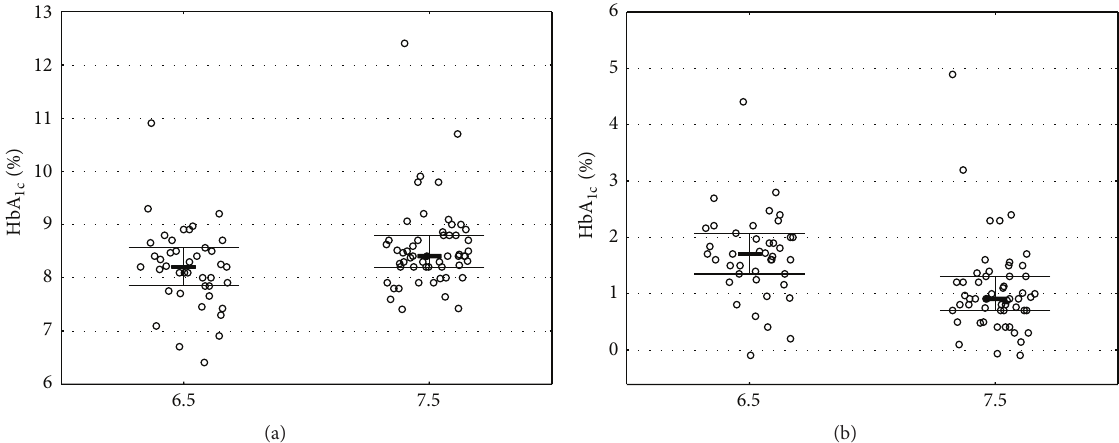
Figure 2: (a) Comparison for HbA 1 c levels between regions of 6.5% and 7.5% as guideline values (MWU test, 𝑝 = 0.0162 ). (b) Comparison of thedifferencebetweenHbA 1 c levelsandguidelineHbA 1 c valuesbetweenregionsof6.5%and7.5%asguidelinevalues(MWUtest, 𝑝 < 0.0001 ). Bolded line represents median; whiskers represent